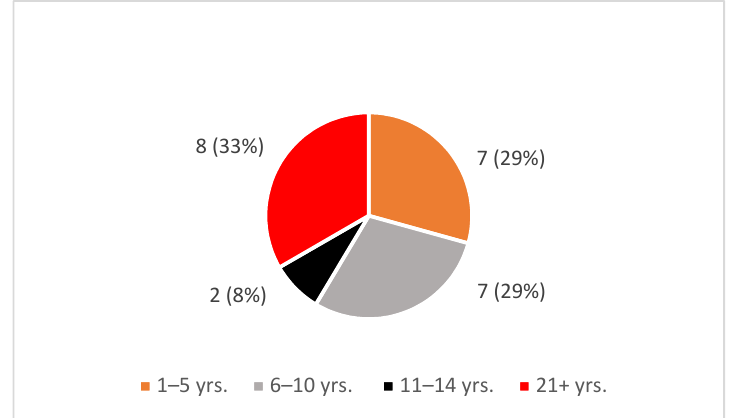
Figure 2. Participant Years of Senior Management Experience.